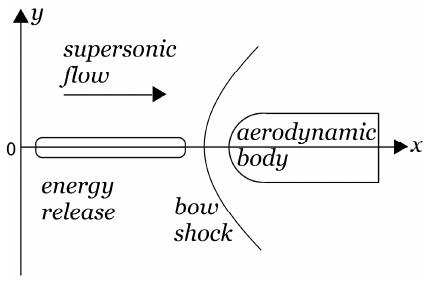
Figure 1. Flow configuration and calculation area.